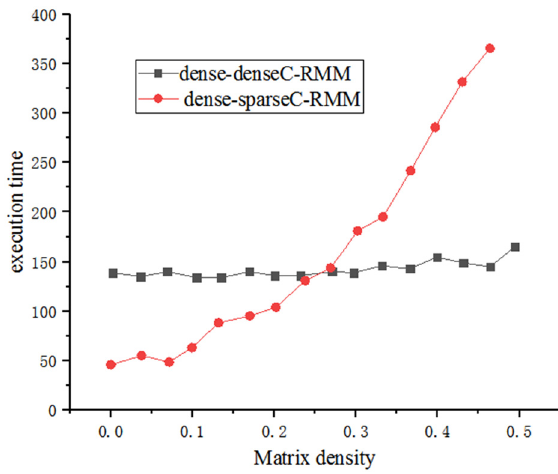
Figure 5: The performance of distributed dense - sparse matrix multiplication varies with matrix